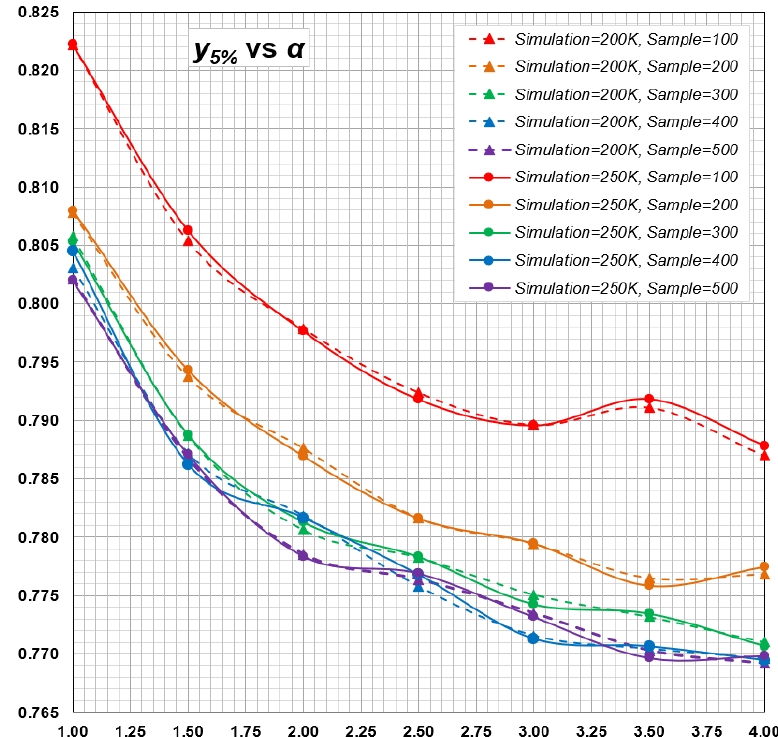
Figure A1. Critical values 𝐲 𝛄 versus shape parameters 𝛂 and sample sizes 𝐧 with 200,000 and 250,000 simulations .